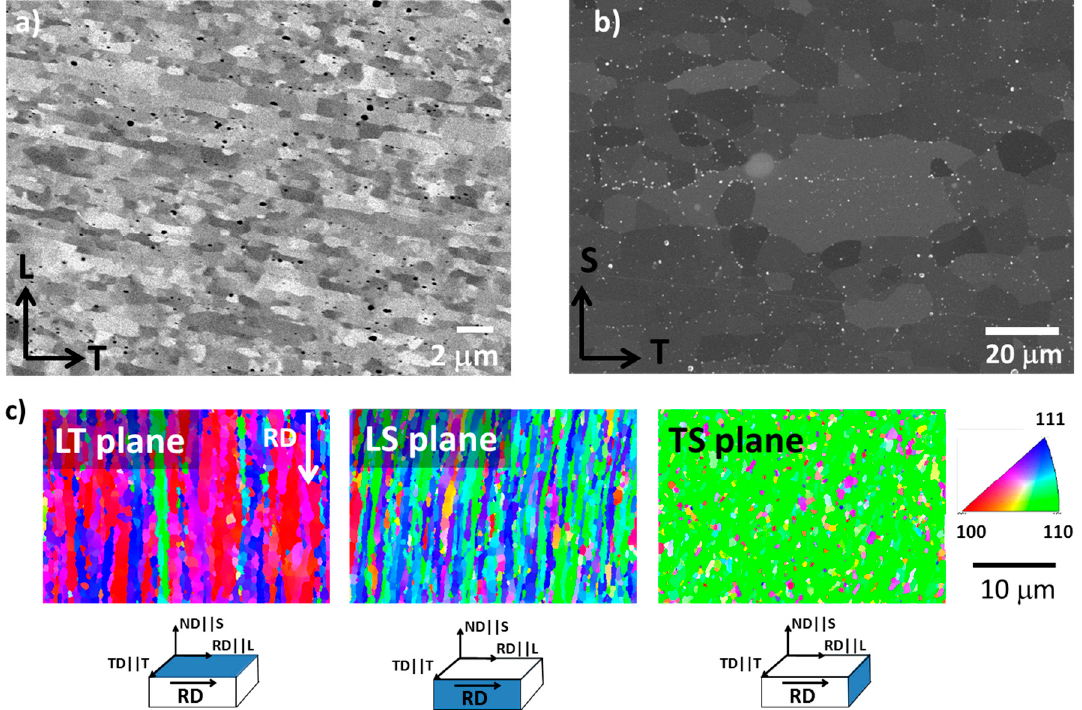
Figure 2. ( a ) Backscattered SEM of Longitudinal-Short transverse plane (LS) for the hot rolled condition; ( b ) secondary electron image of grain boundary particles (in white) in Transversal-Short transverse plane (TS) plane; and ( c ) (inverse pole figure) IPF maps taken in normal direction to means Longitudinal-Trasnverse plane (LT), LS, and TS planes, as shown in Figure 1.